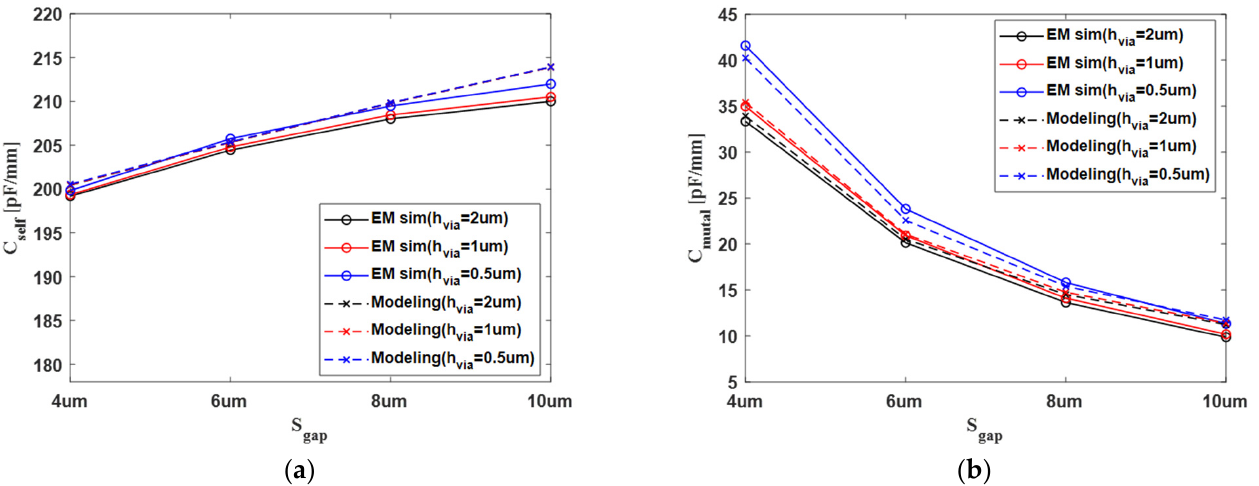
Figure 5. Verification of capacitance modeling: ( a ) self-capacitance and ( b ) mutual capacitance. When the s gap has a value of about 10 µ m, the self-capacitance has a saturated constant value. The 10 µ m is a sufficiently wide gap of the channel because it is 10 times the thickness of the channel. Thus, this modeling of capacitance is presented with sufficient